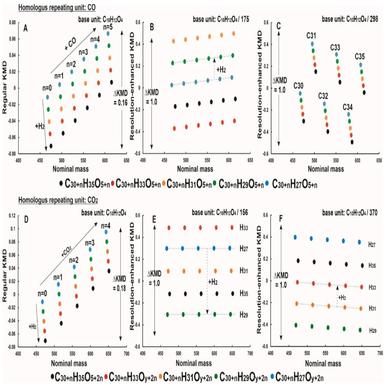
KMD plots for simulated oligomeric structures with homologous repeating units CO (A–C) and CO2 (D-F), and C10H12O4/X Kendrick base unit with X = 1 (A, D), 175 (B), 298 (C), 156 (E), and 370 (F).